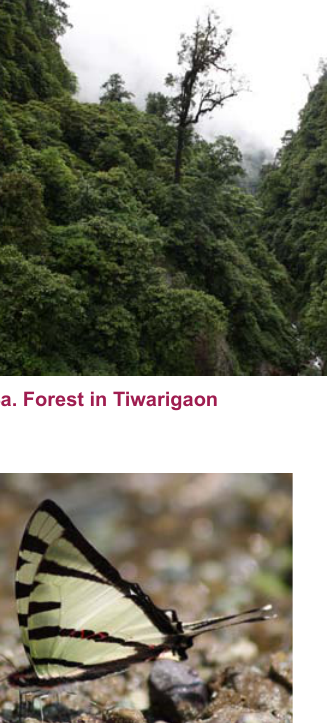
Image 7. Lamproptera meges indistincta